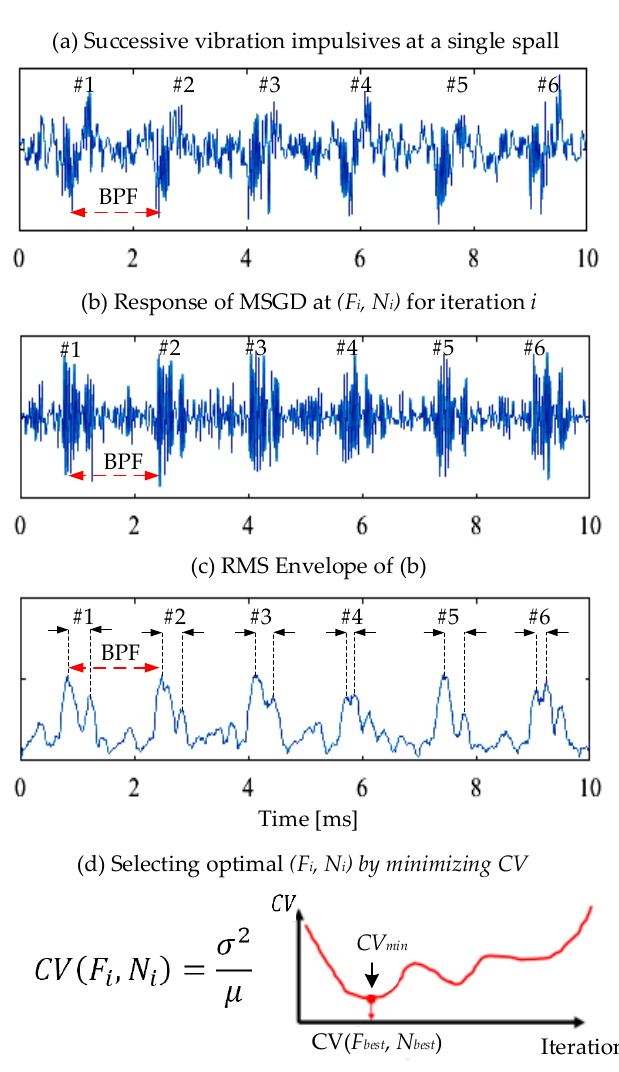
Figure 6. A tuning method for selecting MSGD parameters.